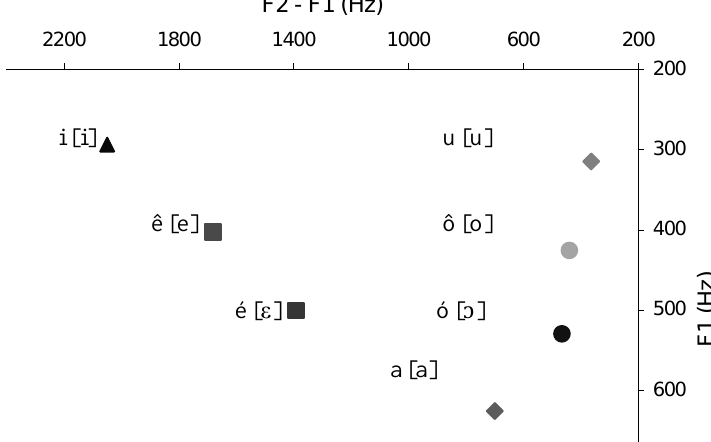
Figure 2: Accented vowels of standard Portuguese, composited from the data of nine speakers (based on data in Martins